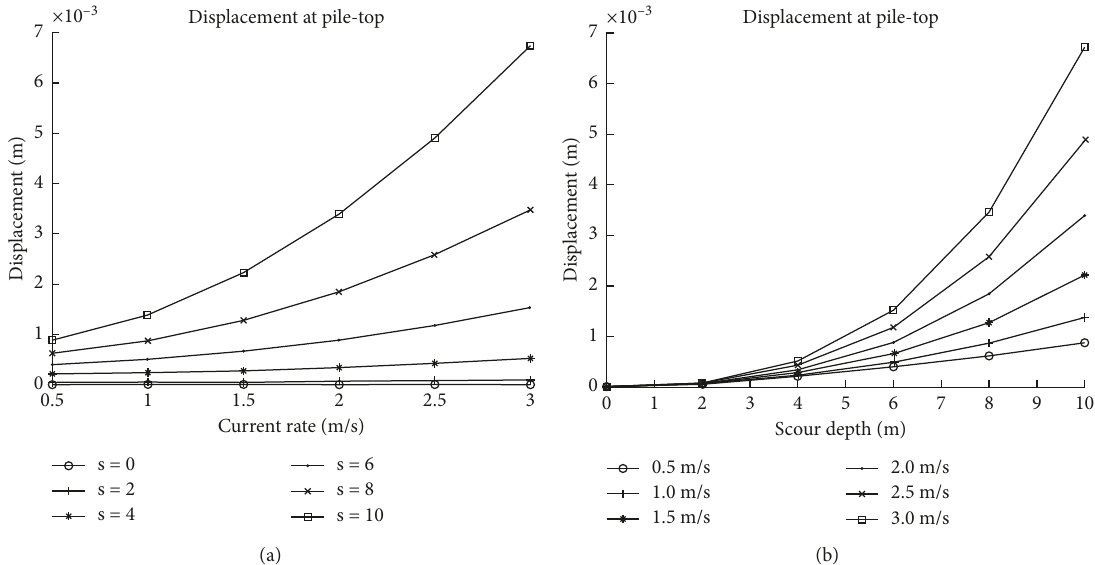
Figure 18: Displacement at the pile top under static loading simulation. (a) Flow velocity. (b) Scour depth.